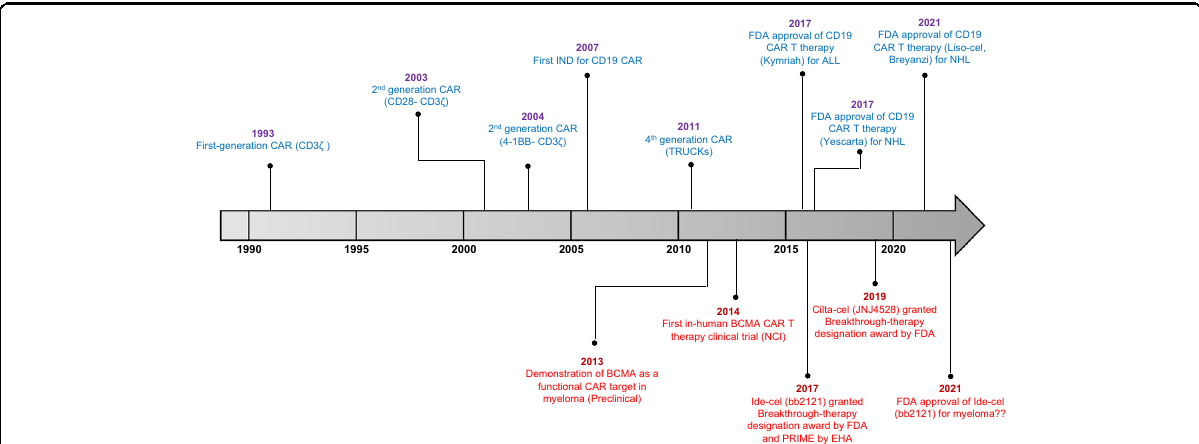
Fig. 1 The time line of CAR T-cell development. The history of CAR T cells and its progress and milestones achieved over the years. Red fonts are the time line for CAR T-cell development in